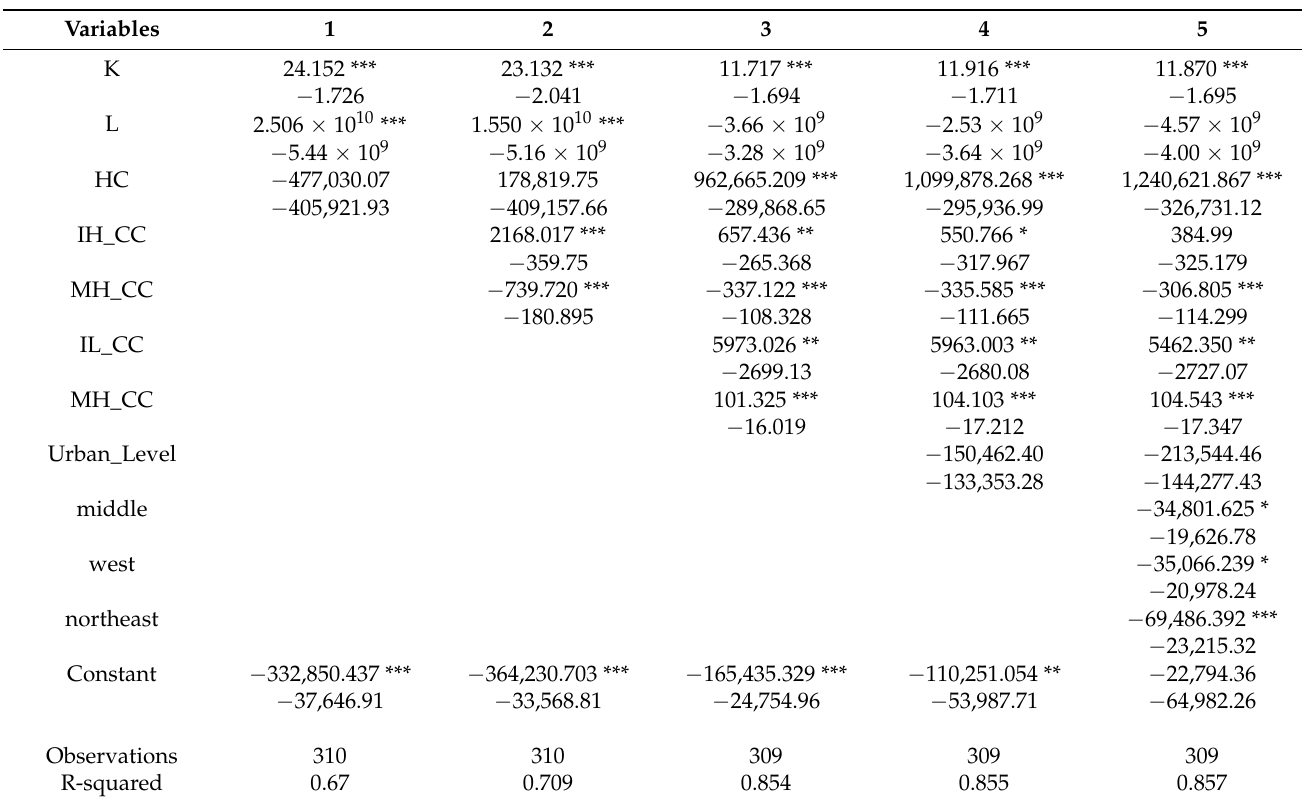
Table 2. Effects of cultural capital on entrepreneurship.